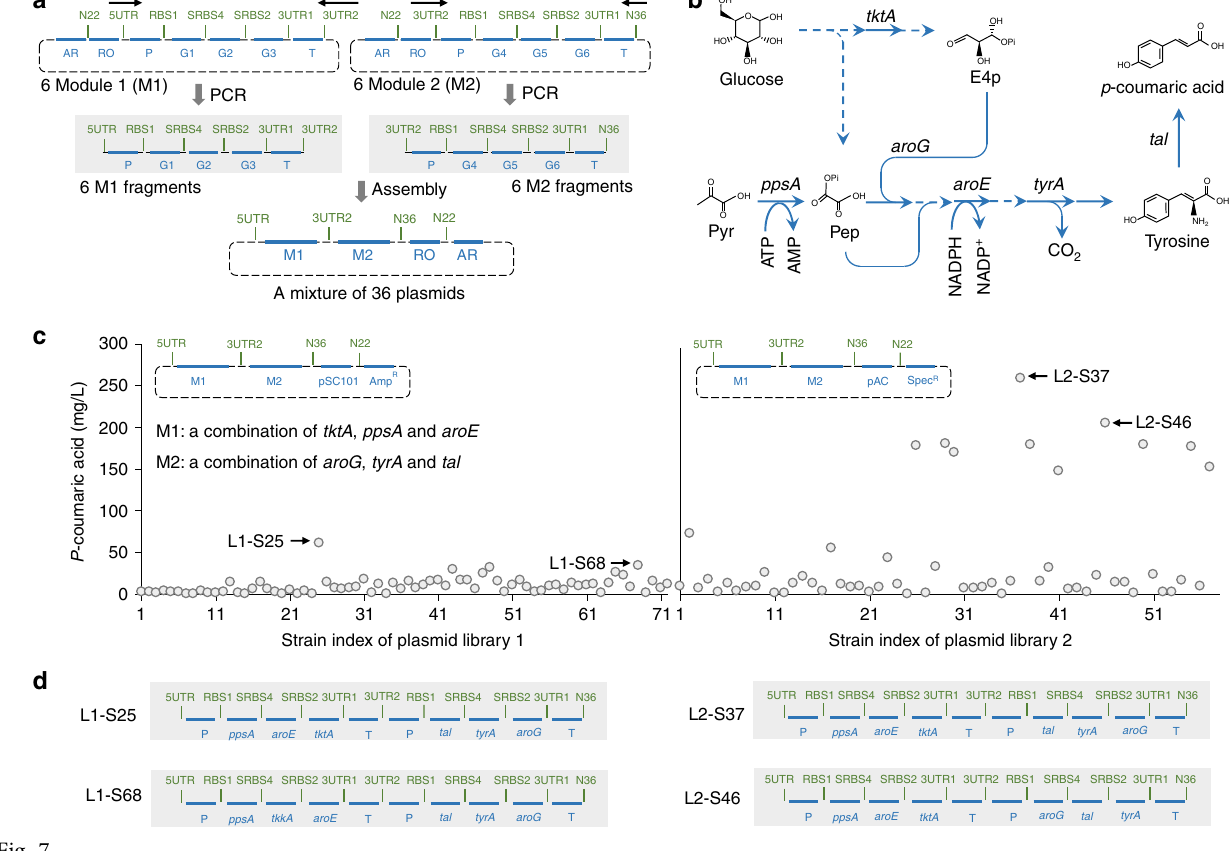
Fig. 7 The correct version as Figs. 6 and 7